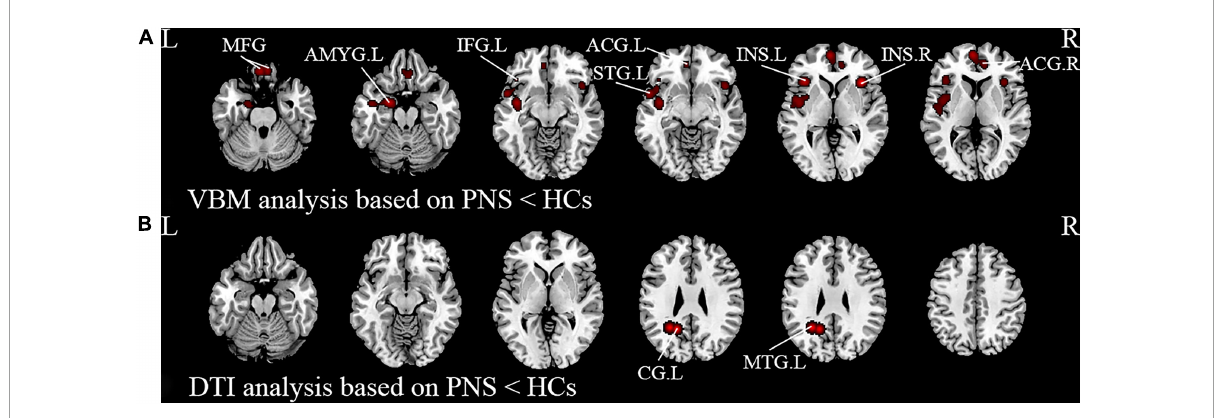
FIGURE2 Results from the activation likelihood estimation (ALE) meta-analysis of structural abnormalities in schizophrenia with PNS. Brain regions showing (A) decreased GMV and (B) decreased FA in PNS patients compared with HCs. Significance threshold with a false discovery rate at p < 0.01. PNS, persistent negative symptoms; HCs, healthy controls; GMV, gray matter volume; FA, fractional anisotropy; VBM, voxel-based morphometry; DTI, diffusion tensor imaging; MFG, medial frontal gyrus; AMYG, amygdala; IFG, inferior frontal gyrus; STG, superior temporal gyrus; INS, insula; ACG, anterior cingulate gyrus; CG, cingulate gyrus; MTG, middle temporal gyrus; R, right; L,